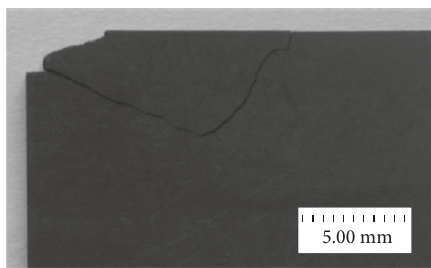
Figure 10: Crack initiation and propagation path formed at in- denter rake angle of 0 ° ( h D (cid:28)